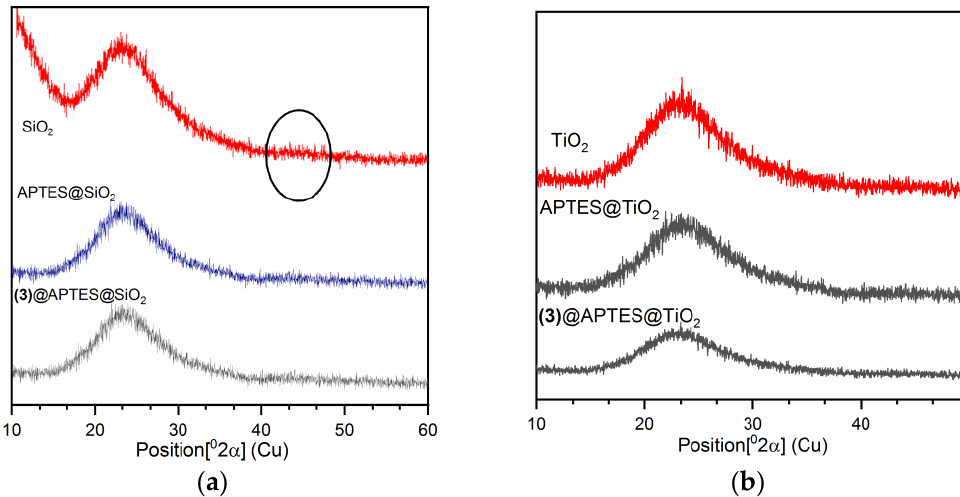
Figure 17. XRD pattern of ( a ) → SiO 2 , APTES@SiO 2 and (3) @APTES@SiO 2 (11) ; ( b ) → TiO 2 , APTES@TiO 2 and (3) @APTES@TiO